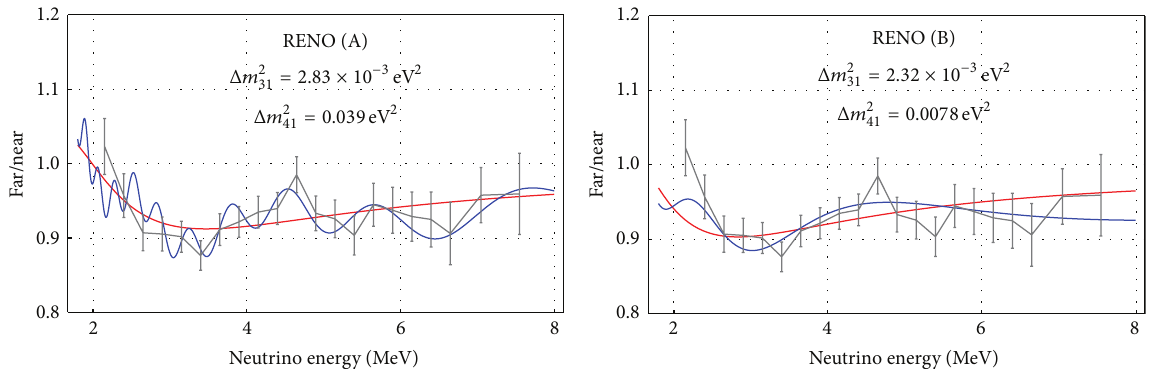
and 𝑅 released by RENO and Daya Bay. Blue (gray) areas Near Far